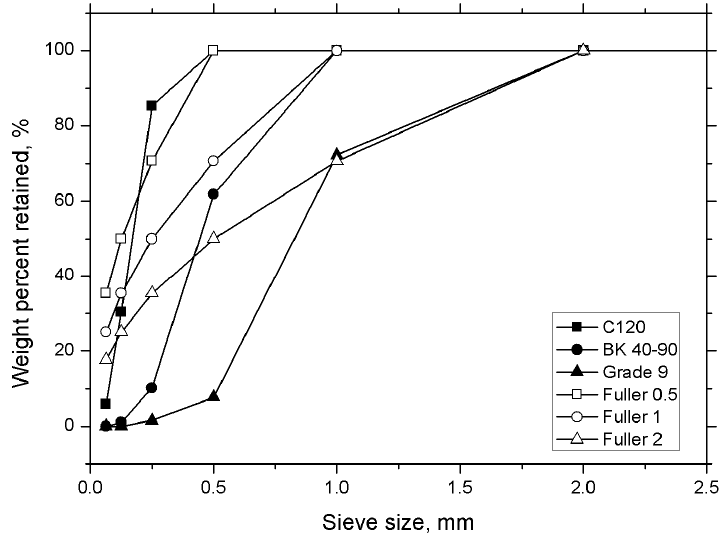
Figure 3. Representation of ideal particle size distribution (Fuller D = 0.5, D = 1, and D = 2) and wood flour size distribution